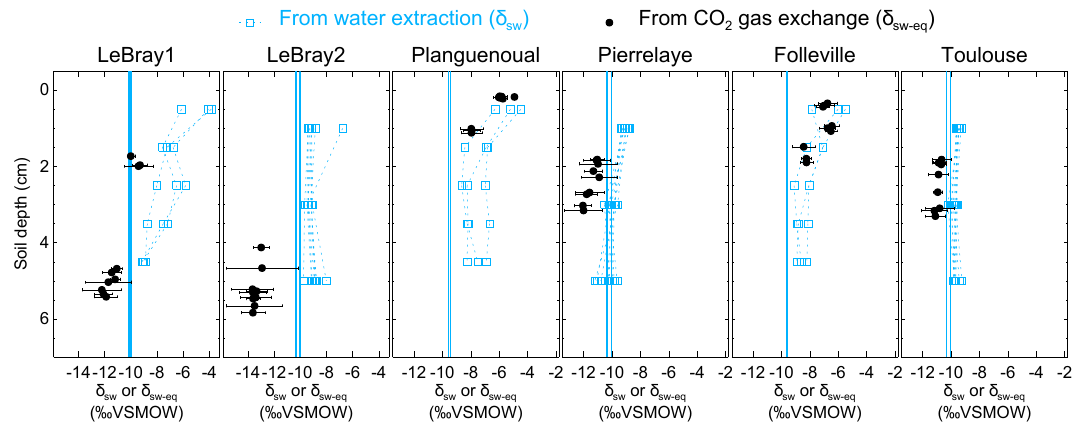
Figure 5. The isotopic composition of soil water at different depths in the replicated soil microcosms from each site, estimated either by vacuum distillation and water isotope analysis ( δ sw , blue squares) or online CO 2 –H 2 O isotopic exchange using the two-steady-state approach ( δ sw-eq , at depth z eq , black circles; see text). Profiles for the different CA treatments are plotted together without distinction (because exogenous CA addition should not affect the isotopic composition of soil water). The blue vertical line also indicates the isotopic composition of the irrigation water used for the re-wetting of the air-dried soils. According to Eq. (11), the addition of exogenous CA shifts the gas exchange results ( δ sw-eq ) to shallower depths ( z eq )